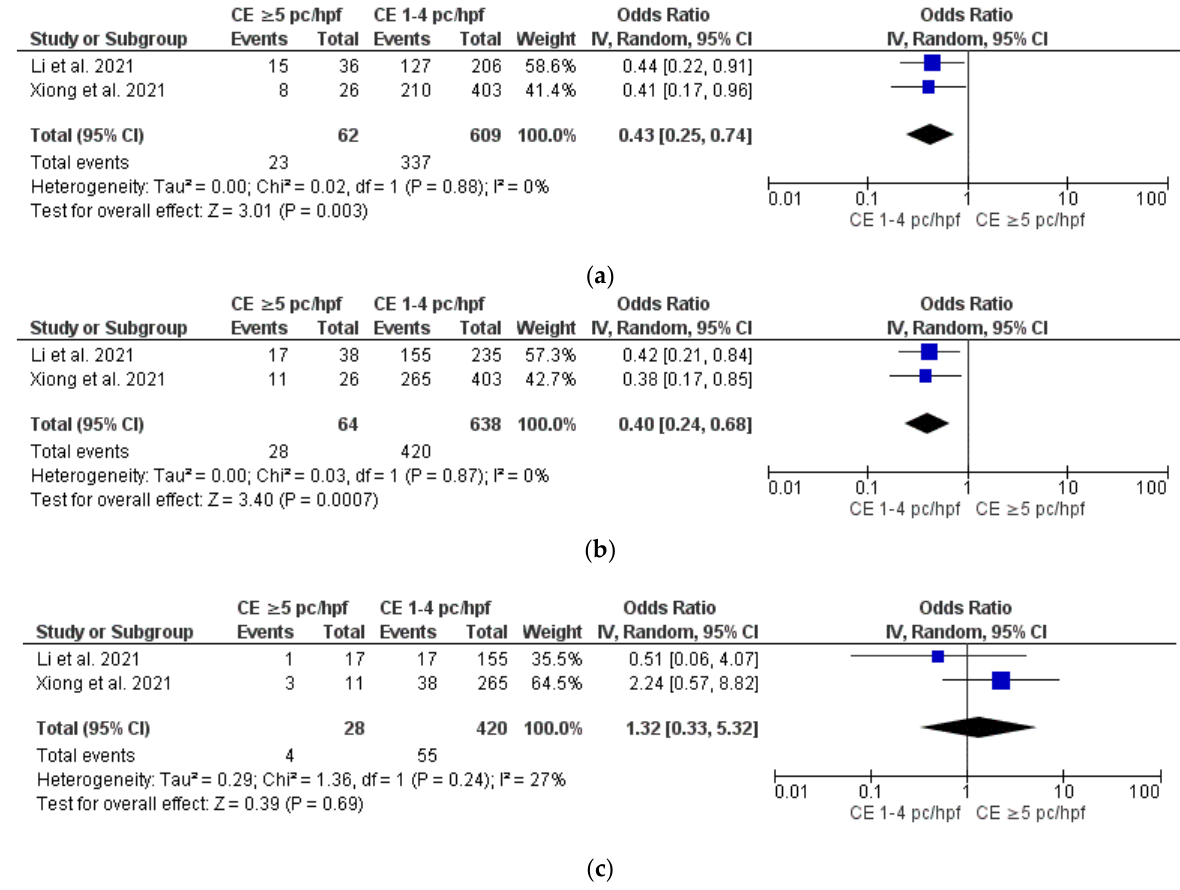
Figure 6. Pooled data analysis comparing severe versus mild CE: ( a ) ongoing pregnancy rate/live birth rate; ( b ) clinical pregnancy rate; ( c ) miscarriage rate [9,10].